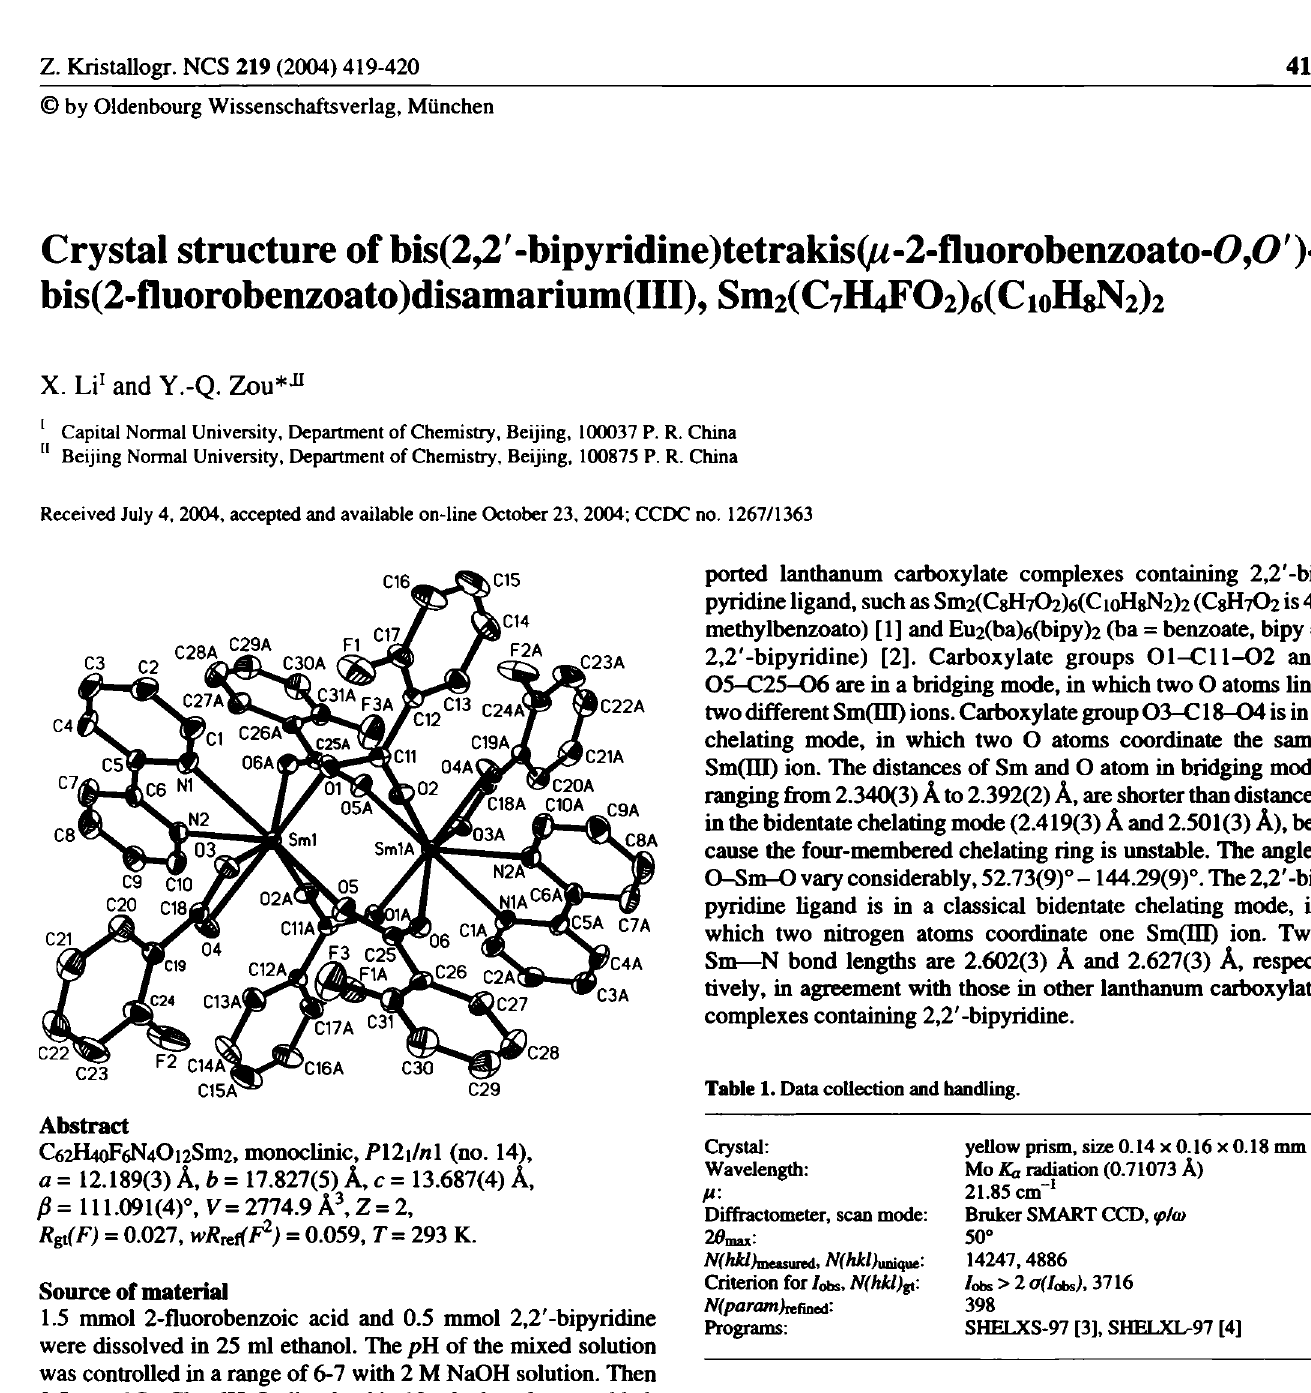
Table 2. Atomic coordinates and displacement parameters (in À 2